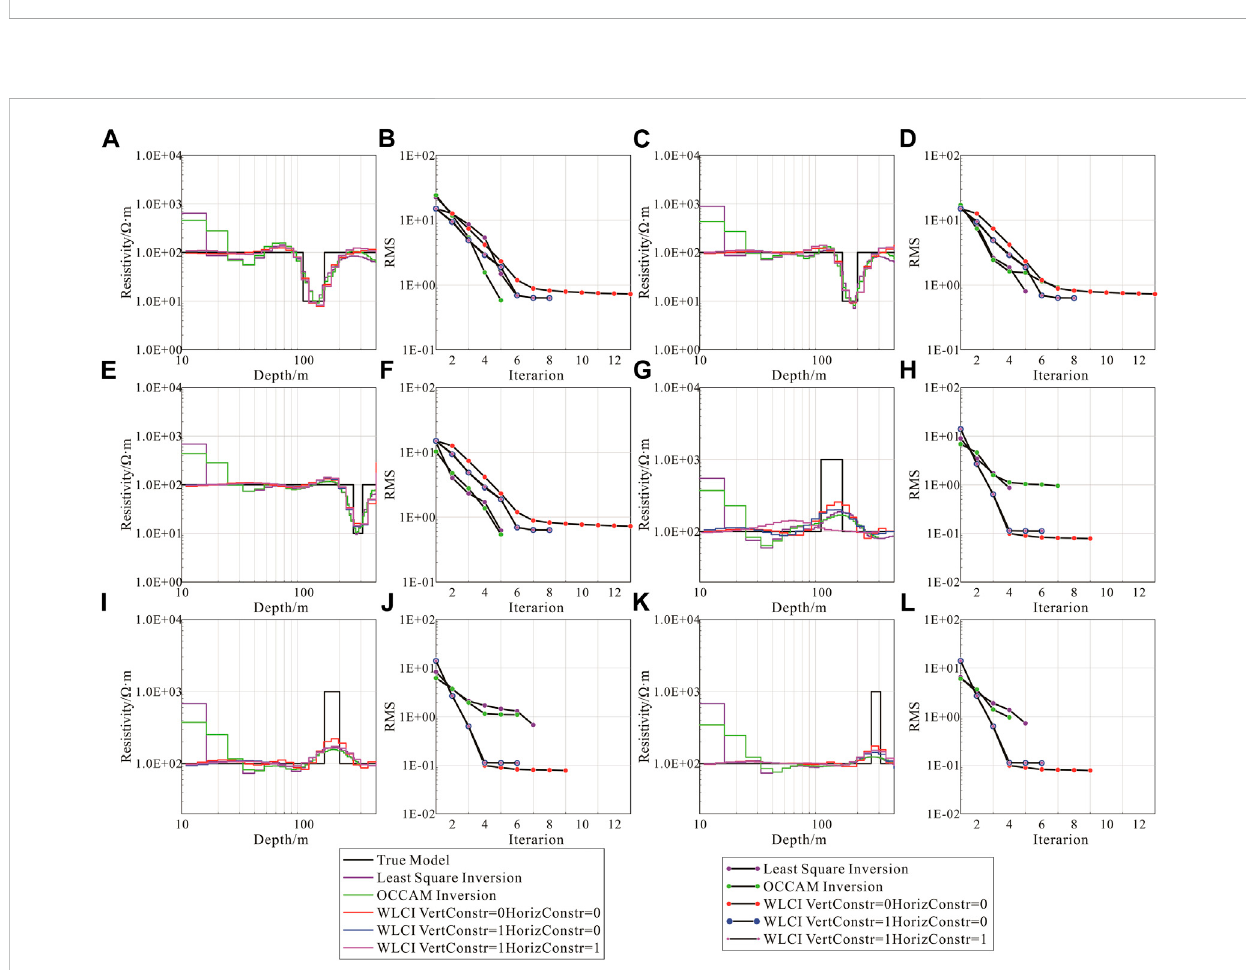
FIGURE 3 Single-pointinversion results for differentpoints. (A) :Single-point inversionresults at X =260 mof H-type model. (B) :TheRoot Mean Square(RMS) at X = 260 m of H-type model. (C) : Single-pointinversion results at X = 600 m of H-type model. (D) : The RMS at X = 600 m of H-type model. (E) : Single- point inversion results at X = 900 m of H-type model. (F) : The RMS at X = 900 m of H-type model. (G) : Single-point inversion results at X = 260 m of K-type model. (H) : The RMS at X = 260 m of K-type model. (I) : Single-point inversion results at X = 600 m of K-type model. (J) : The RMS at X = 600 m of K-type model. (K) : Single-point inversion results at X = 900 m of K-type model. (L) : The RMS at X =900 m of K-type